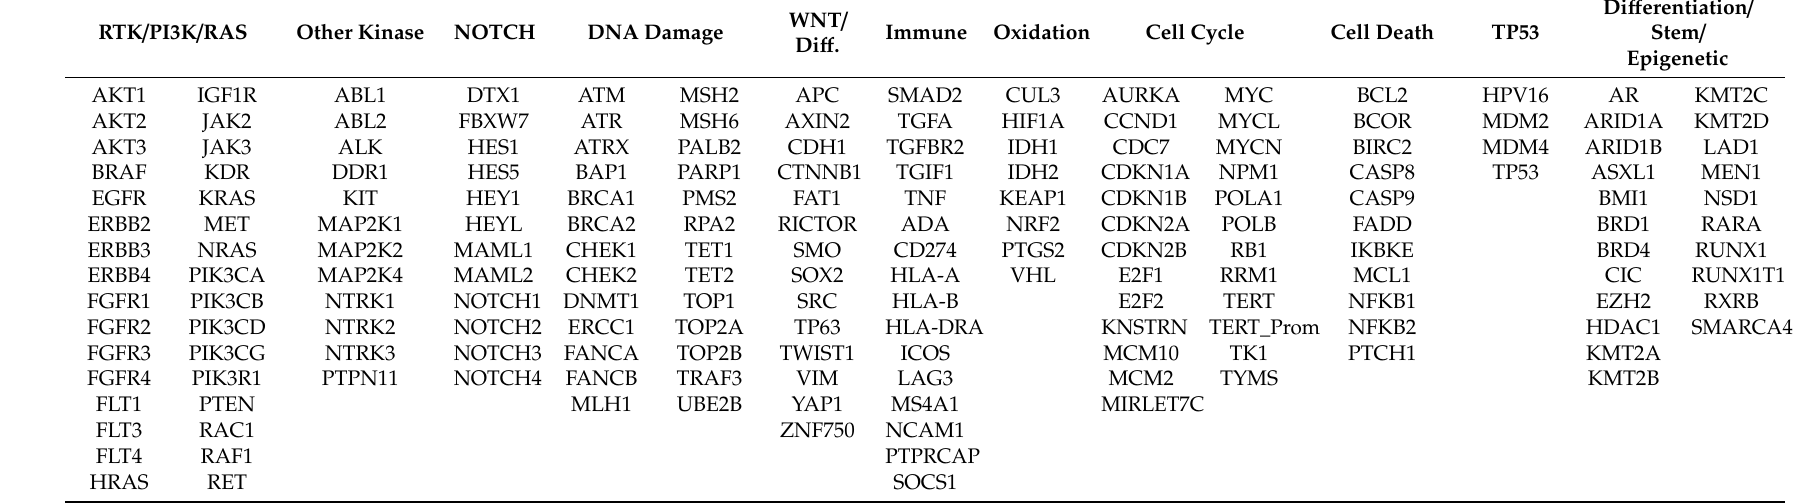
Table 2. Pathway